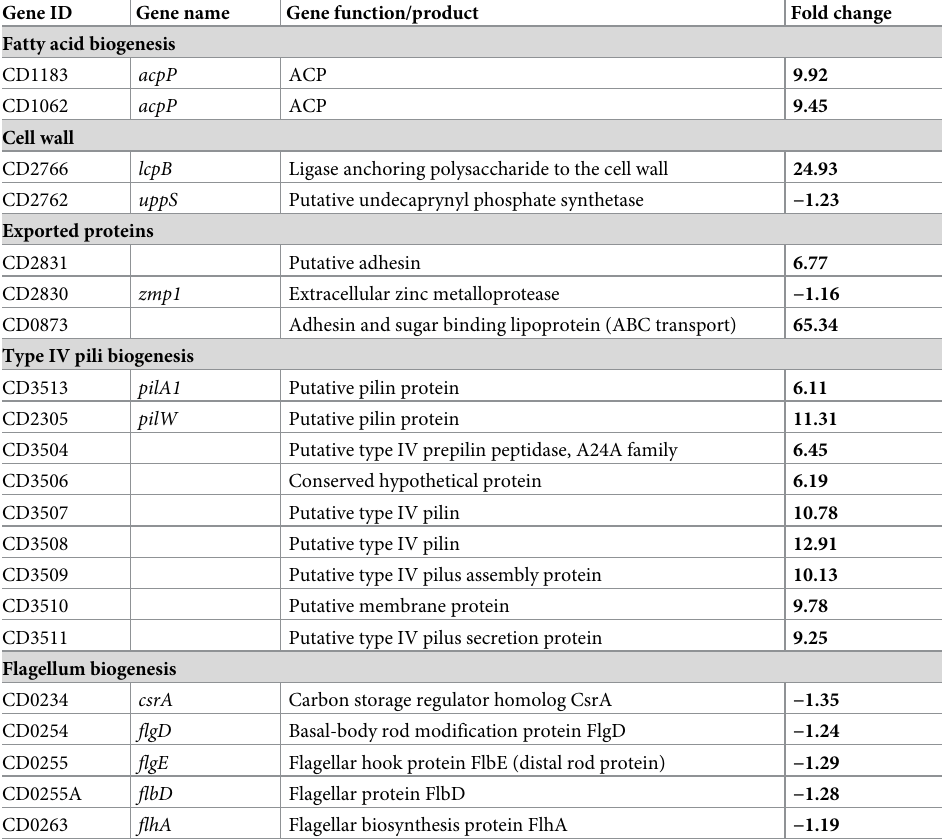
Table 1. Cell surface associated component genes’ expression in 630 Δ erm 72-hour biofilm cells, compared to planktonically grown